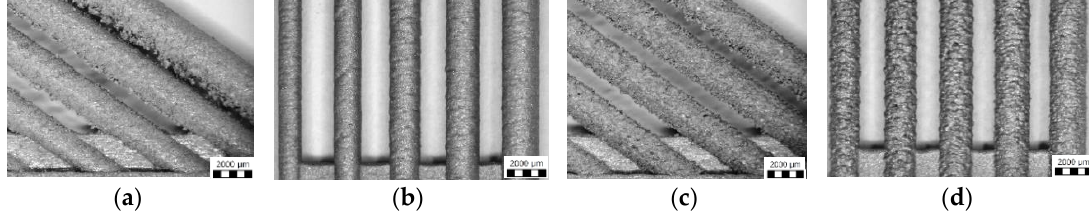
Figure 11. Struts surface quality—produced with higher E in ( a ) at orientation ( OR) 36.26°; ( b ) at OR 90°; produced with lower E in ( c ) at OR 36.26°; ( d ) at OR 90°.